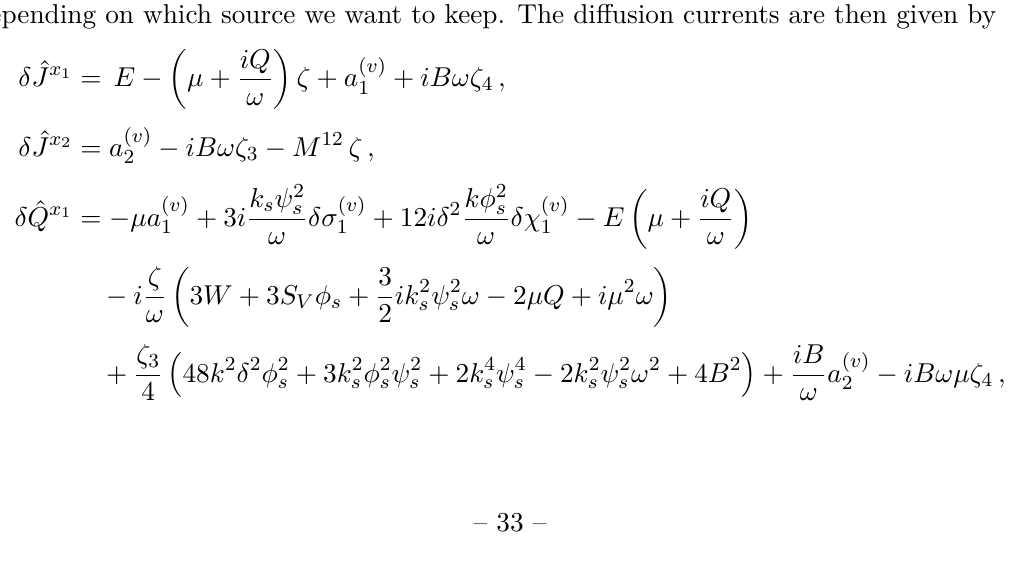
Figure 3 . In the top row we plot the real and imaginary part of the gap, ω g , as functions of the magnetic field B for φ s = 10 − 4 . In the bottom row we plot the real and imaginary part of ω + functions of the magnetic field φ s for B = 1 / 200 . The dashed lines represent the analytic formula of the previous section, which is exact in B and perturbative in φ s . Here ( ψ s , T, µ, k, k s , γ, δ ) = (cid:1) (cid:0) 4 , 1 , 1 , 3 , 3 , 3 , 1 100 20 10 2